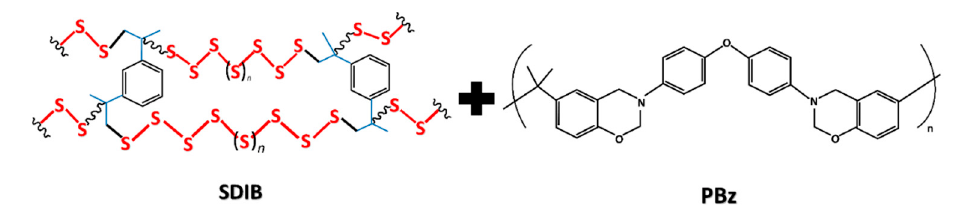
Figure 3. Polymer blending of SDIB and PBz with chemically aromatic structures.